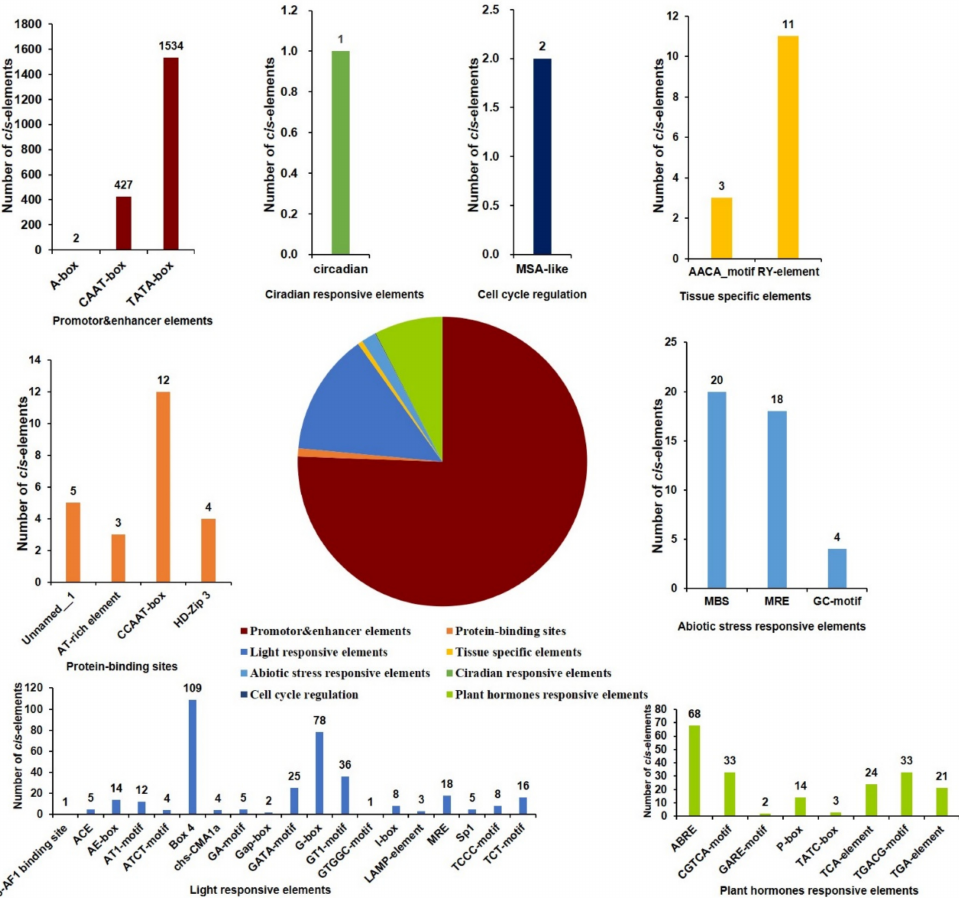
Figure 4. The analysis of cis -regulatory elements in the putative promoter of the AP2 subfamily genes. The pie chart shows the classification of cis -regulatory elements, and the corresponding color chart displays the frequency of different